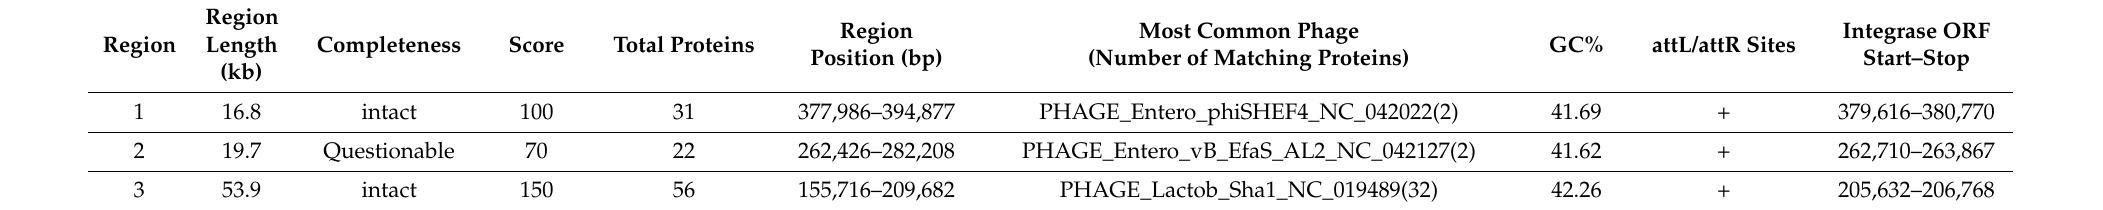
Table 6. Prophage regions of Lactiplantibacillus plantarum DJF10 identified in